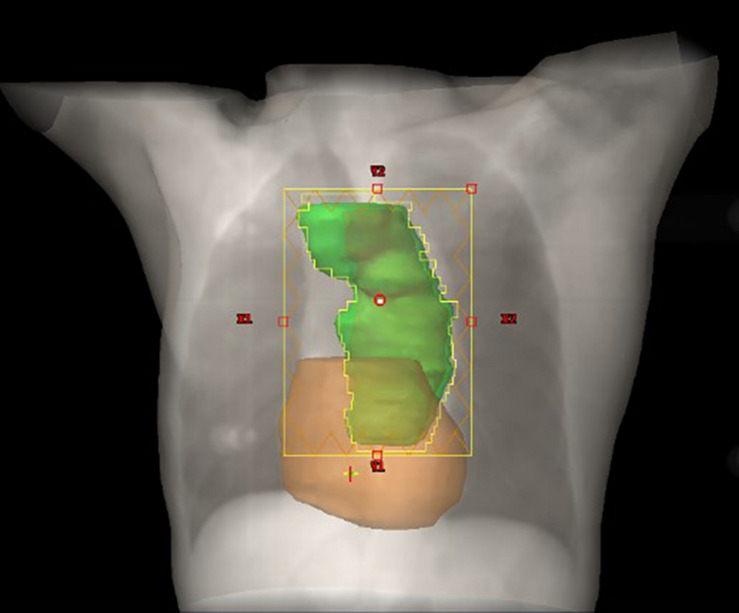
Schematic diagram of the relationship between the heart and PTV. The PTV and heart are depicted in green and color, respectively.